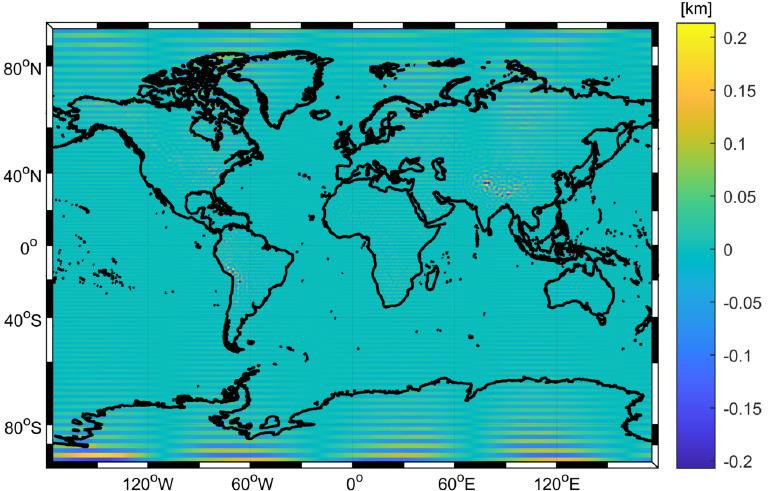
Figure 10. Map of the differences between the estimated Moho obtained starting from two different initial points (zero undulation vs. true Moho, namely s2a and s2b,